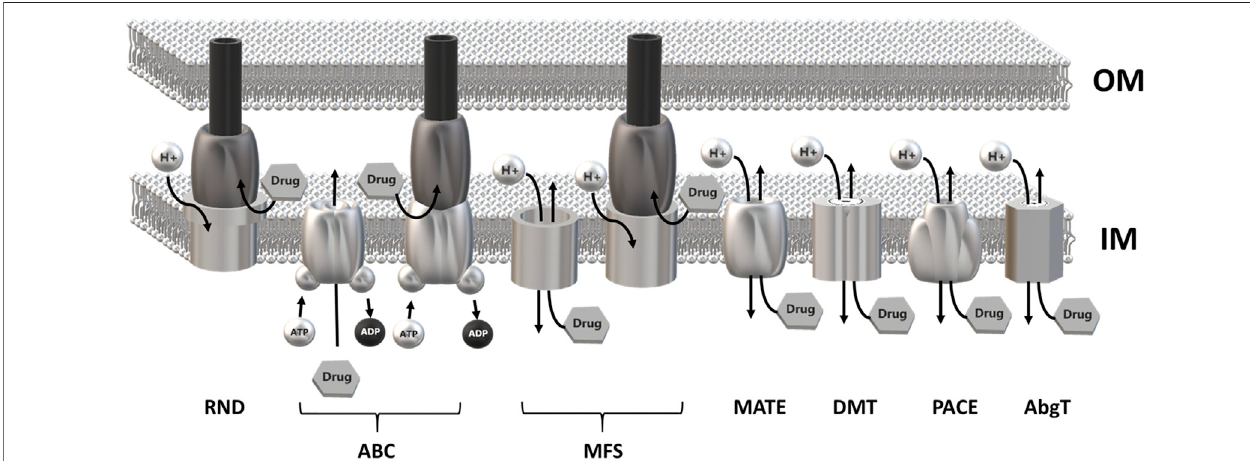
FIGURE1| Schematicoverviewofthemajorfamiliesofmultidrugef fl uxpumps.MostMDREPsaresingle-componentef fl uxtransporterembeddedwithintheinner membrane.MembersoftheRNDfamilyformtripartiteef fl uxpumpscomprisinganinnermembranetransporter,aperiplasmaticadaptorproteinandanoutermembrane factor. Tripartite complexes are also present among members of the ABC and MFS superfamily. The outer membrane channel is usually constituted by TolC or a TolC- like protein. Most MDR EPs use the proton motive force of the inner membrane as energy source with the exception of the ABC superfamily which relies on ATP hydrolysis. RND, Resistance-Nodulation cell Division superfamily; ABC, ATP Binding Cassette superfamily; MFS, Major Facilitator Superfamily; MATE, Multidrug and Toxic Compound Ef fl ux family; DMT, Drug/Metabolite Transporter superfamily; PACE, Proteobacterial Antimicrobial Compound Ef fl ux family; AbgT, p-Aminobenzoyl- glutamate Transporter